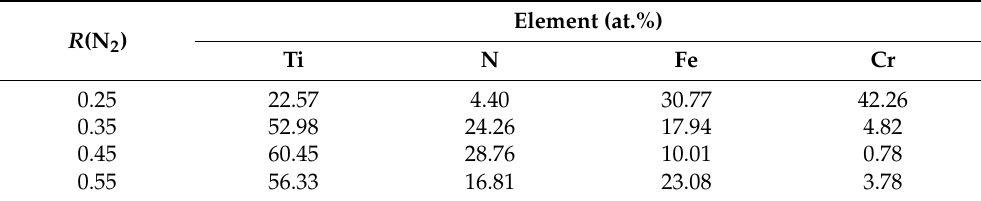
Table 2. EDS analysis of the wear scars corresponding to the white frame in Figure 8 of the four TiN coatings under 20 N load under unlubricated